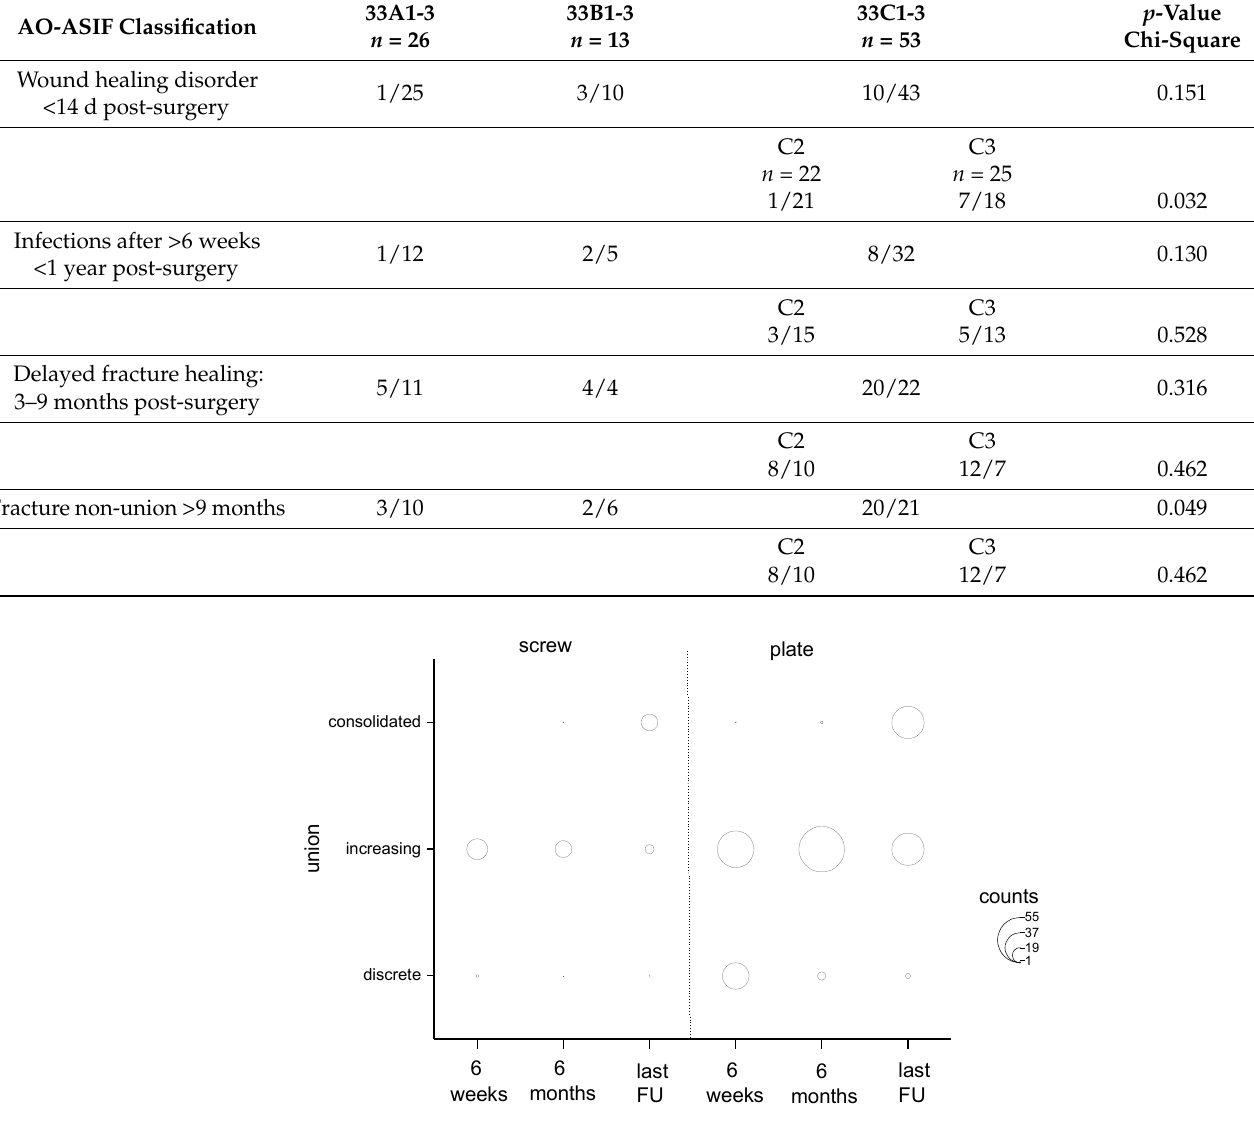
Figure 3. Osseous union time between groups 1 and 2.